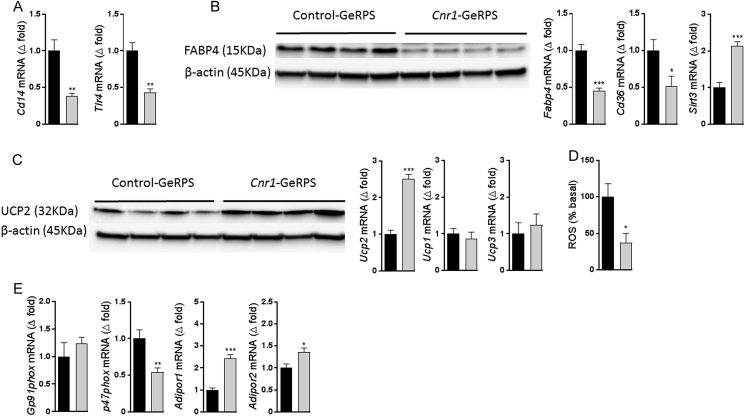
In vivo Cnr1 knock-down in KCs reduces oxidative stress. A Gene expression for CD14 and TLR4 in Kupffer cells. B Representative western blot showing FABP4 protein levels in Kupffer cells isolated from obese mice treated with either control or Cnr1-GeRPs and gene expression for Fabp4 and Sirtuin-3 (Sirt3). C UCP-2 protein and gene expression along with Ucp1 and Ucp3 gene expression in Kupffer cells. D Reactive Oxygen Species (ROS) produced by Kupffer cells isolated from obese mice treated with either control or Cnr1-GeRPs. E Gene expression for Gp91phox, p47phox, AdipoR1, and Adipor2 in isolated Kupffer cells from obese mice treated either with control (black columns) or Cnr1-GeRPs (grey columns). Columns and bars represent means ± SEM. Significant differences from values in control-GeRPs treated obese mice *P < 0.05, **P < 0.01, ***P < 0.001.